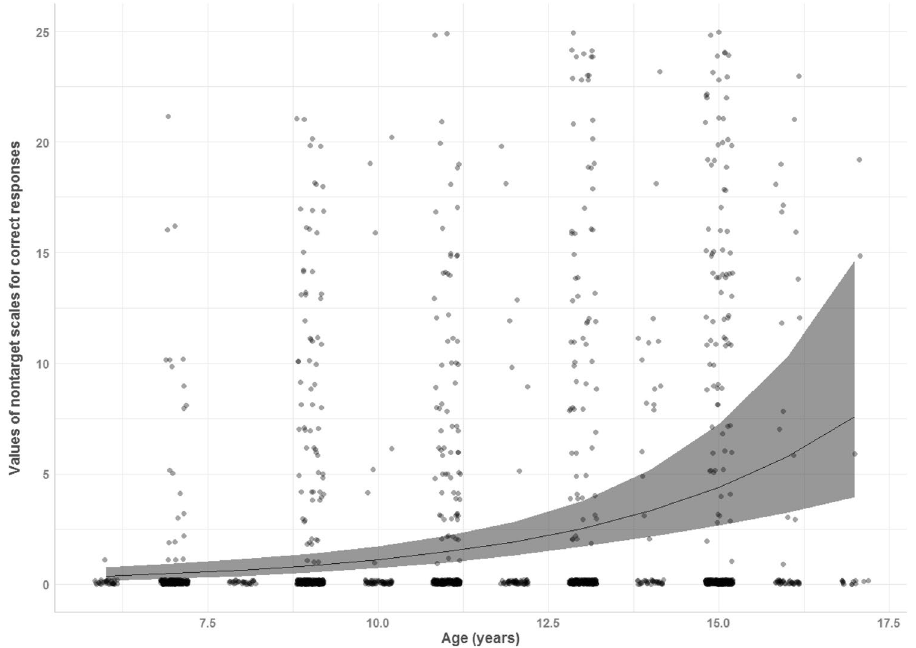
Figure 2. Proportion of correct responses as a function of age and